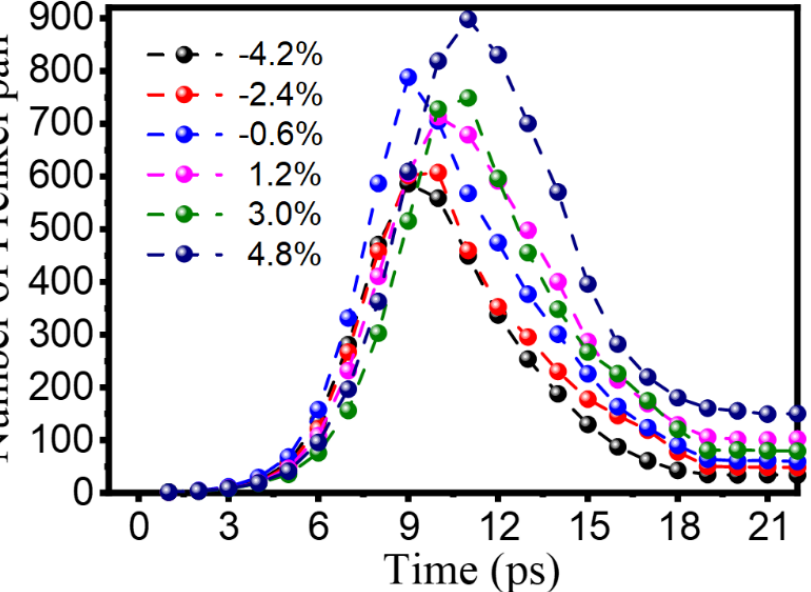
Figure 3. The evolution of as Frenkel pairs (FPs) created during the displacement cascade of 10 keV as volume change. Each point is the average of overall direction and timing, i.e., 16 different samples. A similar thermal spike trend for all given PKA energies was noticed; hence the typical behavior of damage evolution over time was shown with 10